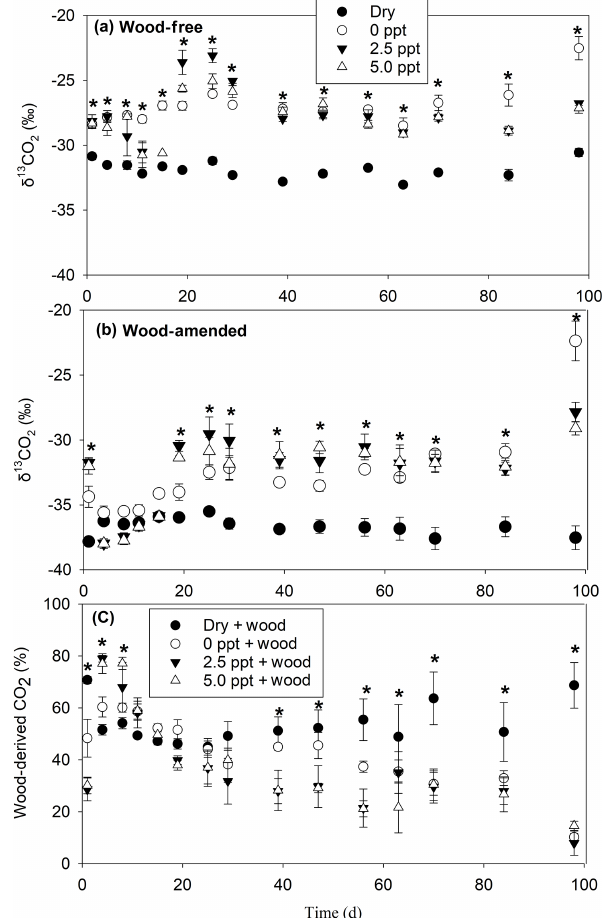
Figure 4. The δ 13 CO 2 values measured over the course of the 98d laboratory incubation for wood-free soils (a) , wood-amended soils (b) , and the proportion of wood-derived CO 2 (c) . Bars repre- sent the mean with standard error ( n = 4). An asterisk ( P < 0 . 05) indicates significant differences between treatment means at each time